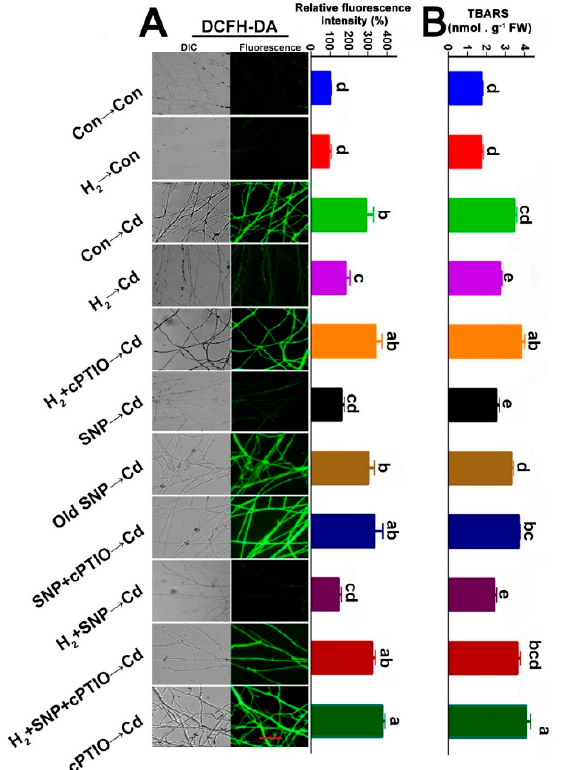
Figure 8. H 2 -reestablished redox balance was sensitive to NO removal. Two-day-old mycelia were either pre-treated or not with 3% H 2 fumigation for 24 h. Stressed mycelia were either treated or not with 500 µ M SNP, 500 µ M old SNP, or 500 µ M cPTIO alone or in the indicated combinations for 30 min after H 2 pre-treatment. Then, mycelial discs from the different treatments were cut and grown on either stressed or non-stressed solid CYM for 5 days. Then, the mycelia were loaded with DCFH-DA for ROS analysis ( A ). Scale bar = 100 μ m. TBARS contents were also determined ( B ). Mycelia without chemicals were used as control (Con → Con), while H 2 alone treated mycelia were represented as H 2 → Con. Bars with different letters are significantly different at p < 0.05 according to one-way ANOVA with multiple comparison using Tukey’s test.